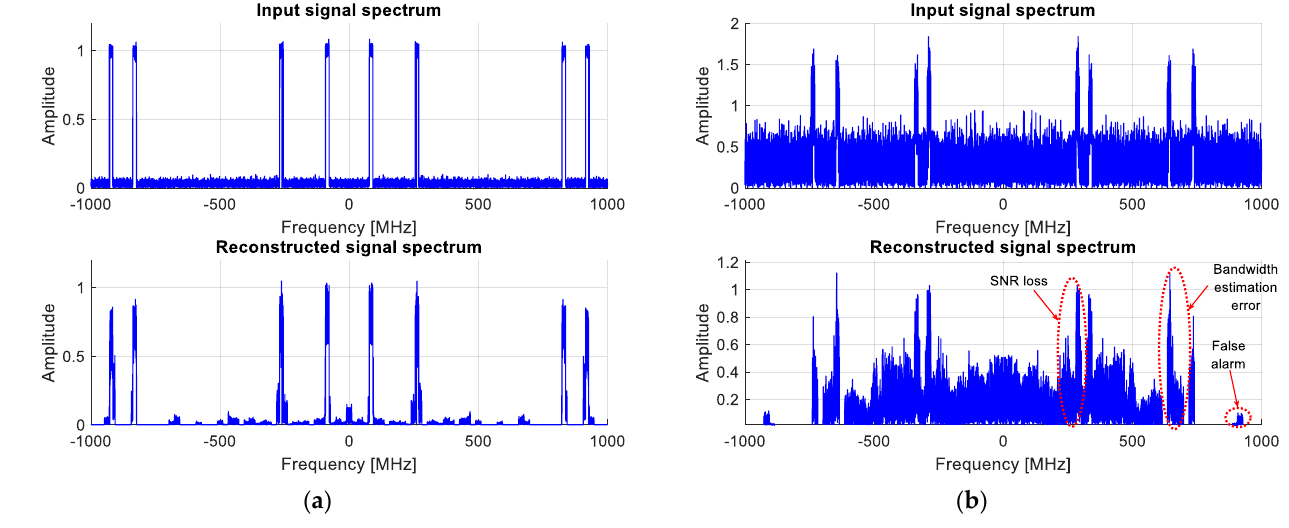
Figure 3. Wideband spectrum sensing results obtained using the invariant LASSO algorithm, for an In-band SNR of ( a ) 30 dB; ( b ) 10 dB.